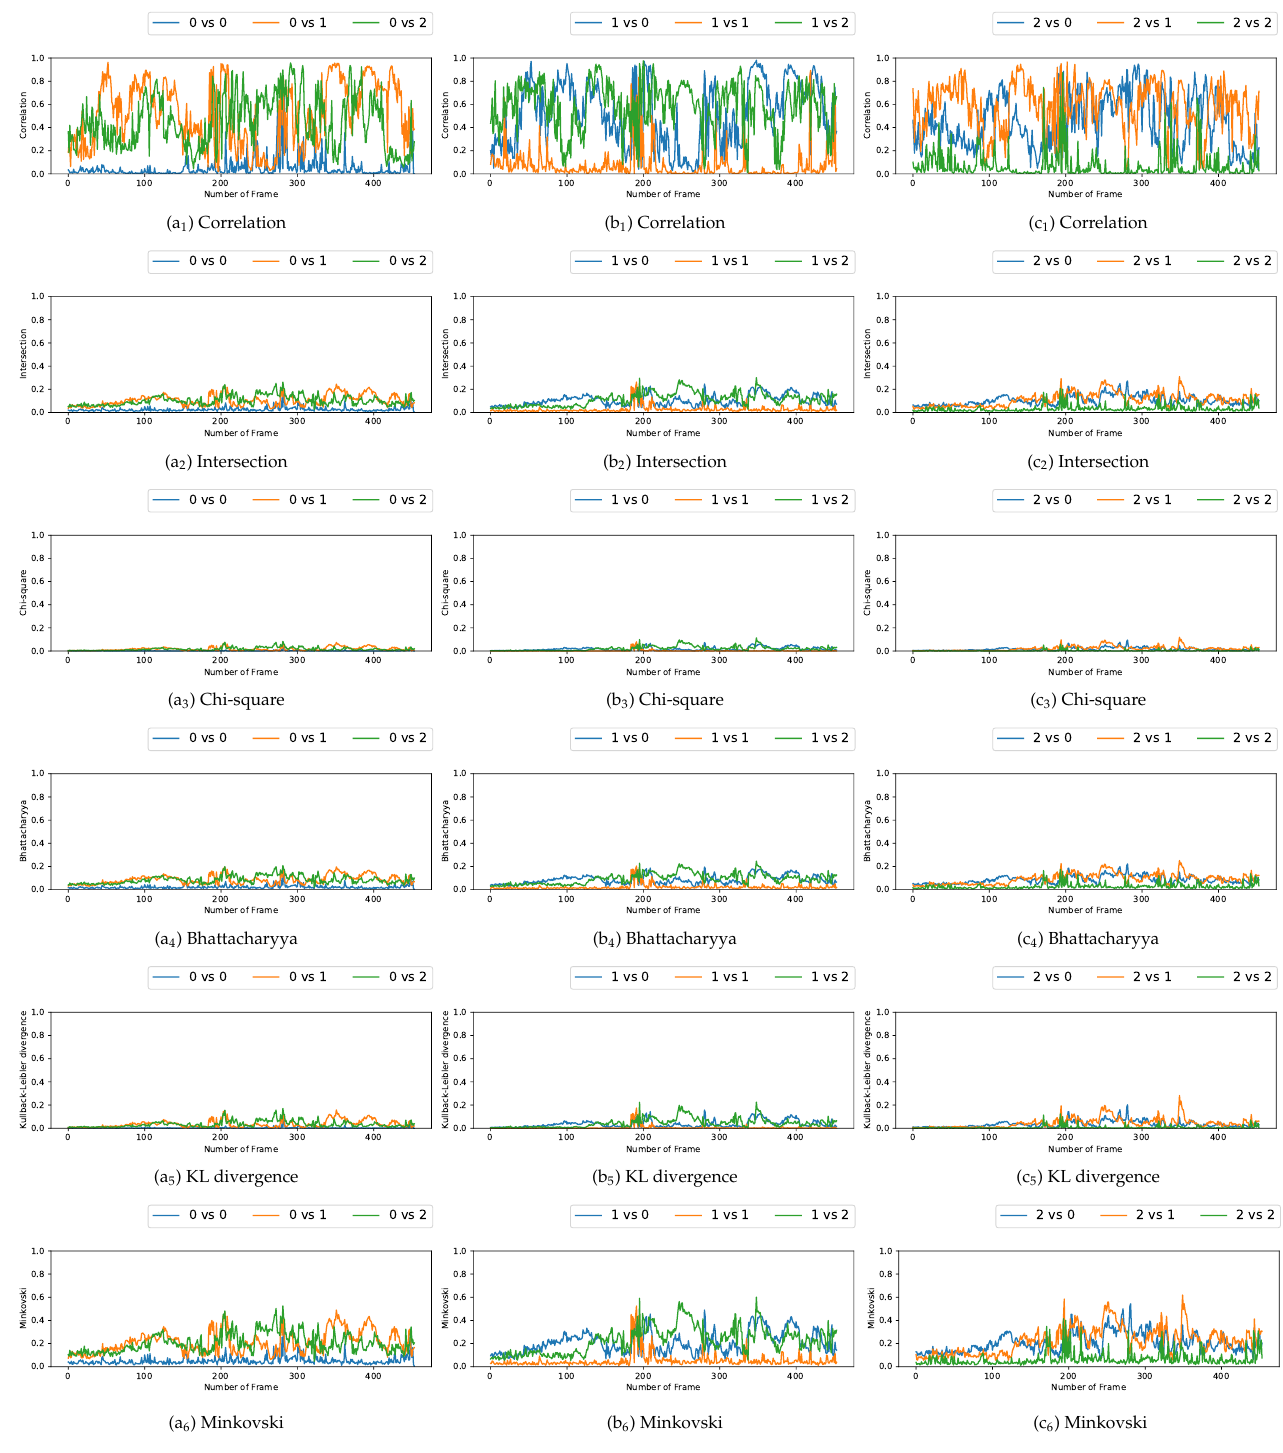
Figure 9. Curves comparing persons from one frame to another in video 2 (persons 0, 1, and 2) using the